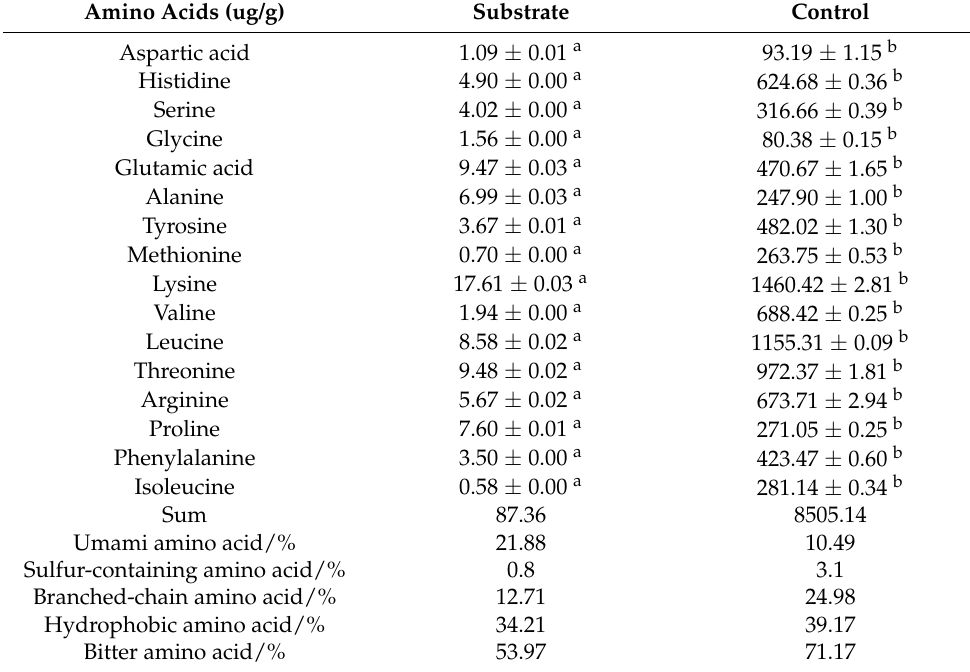
Table 2. Compositions and concentrations (ug/g) of free amino acids of the starting substrate and the proteolyzed